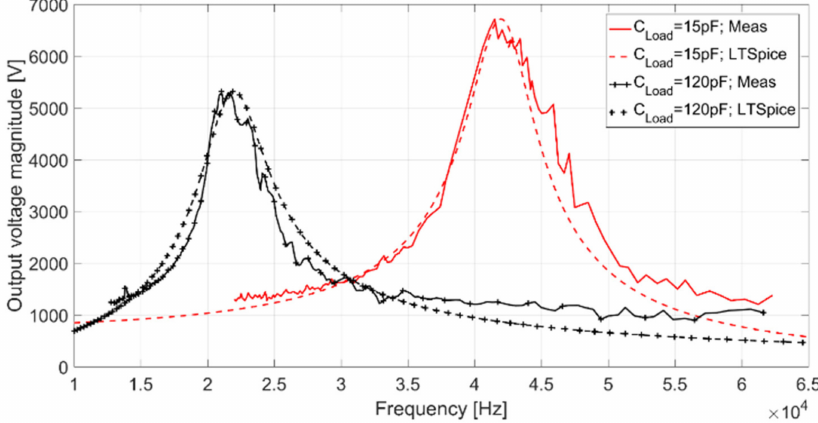
Figure 8. Comparison between measured and computed output voltages as a function of the switching frequency.